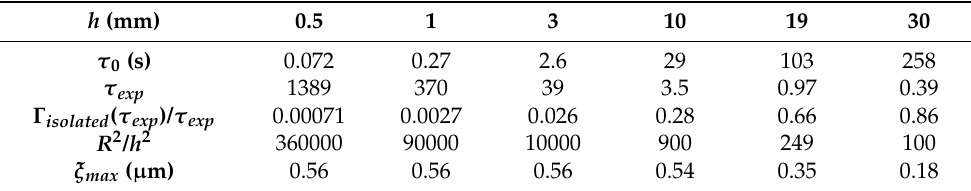
Table 3. Variation of the disc thickness h for float glass, R = 600/2 mm and t exp = 100 s.